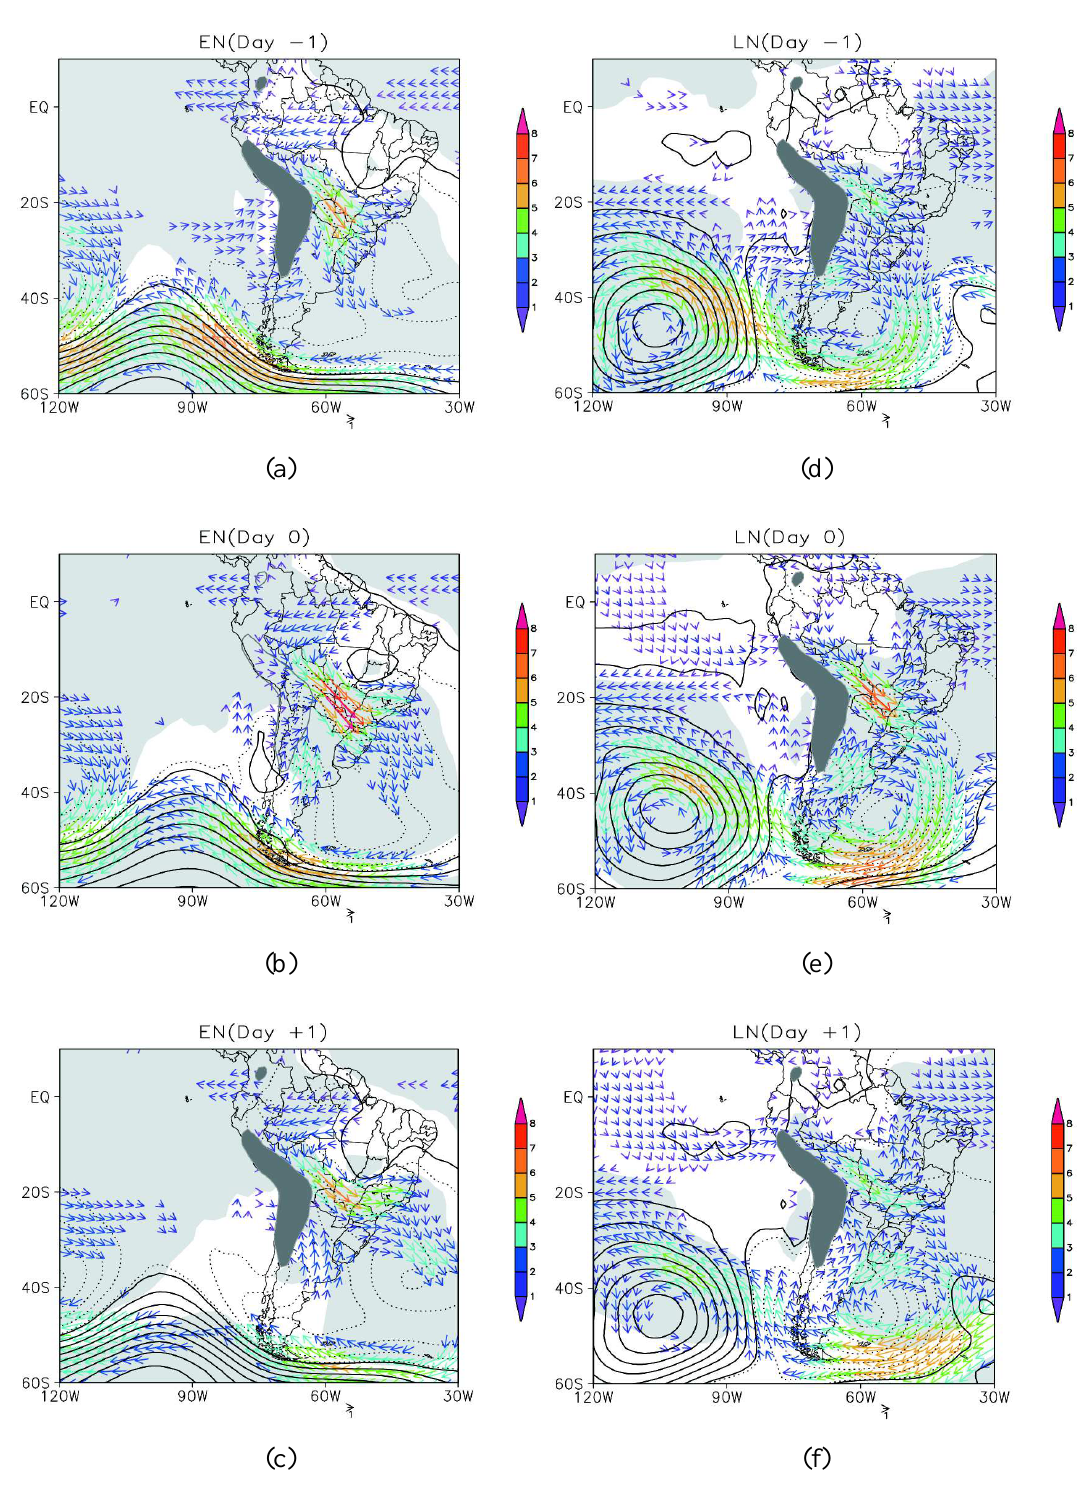
Fig. 6. Same as Fig. 4 but for the 850hPa wind and SLP anomalies. Contour interval is 1hPa. Negative contours are dashed and the zero Figure 6. Same as Fig. 4 but for the 850 hPa wind and SLP anomalies. Contour interval is 1 contours are omitted. A reference vector of 1ms − 1 is shown at the lower right-hand side of each panel. The vector wind plotted and areas hPa. Negative contours are dashed and the zero contours are omitted. It continues... where anomalies are statistically significant at the 95% level are shaded in